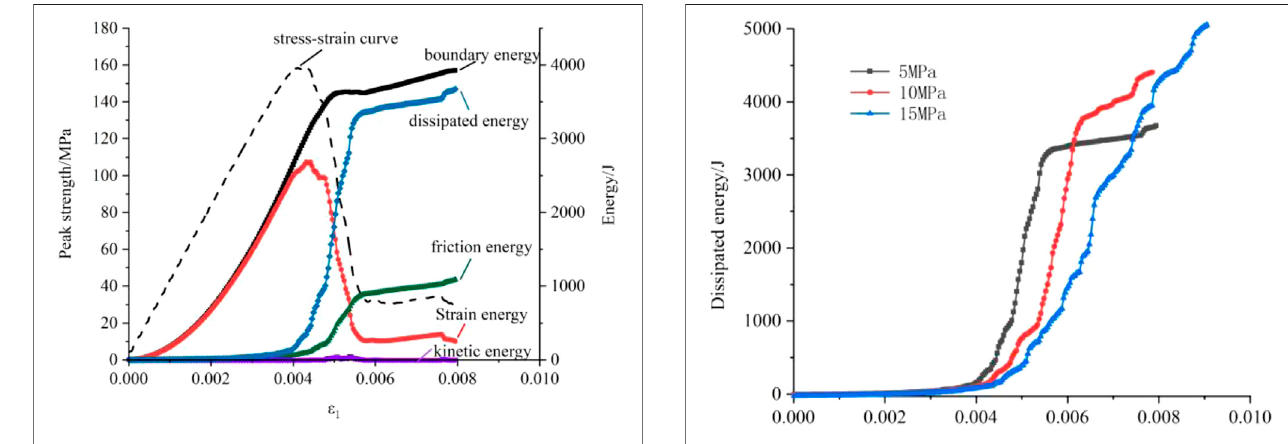
FIGURE 6 | Energy-strain curve.